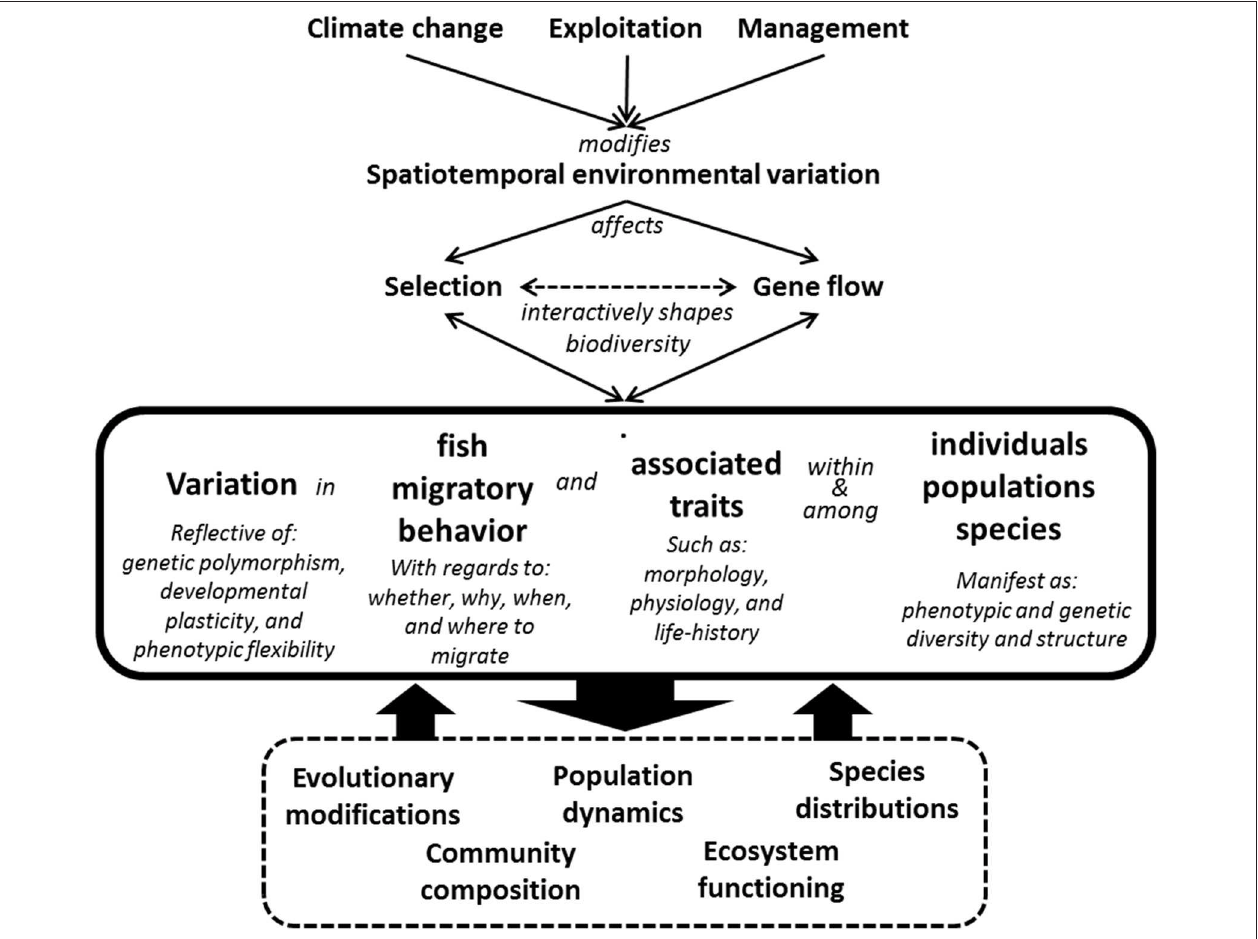
FIGURE 1 | Overview of causes and consequences of variation and flexibility in fish migration. Fish migratory behaviors and associated phenotypic traits vary within and among individuals, populations and species. The phenotypic differences are reflective of the combined contributions of genetic differences, developmental plasticity, and phenotypic flexibility. The costs and benefits of migratory behaviors are context dependent in that they vary according to individual attributes (see Table 1 ) and are influenced by interactive ecological and evolutionary processes in response to spatiotemporal environmental heterogeneity. Climate change and anthropogenic activities result in environmental makeovers and can further modify the opportunities for migration, the direction and strength of selection, genetic diversity, and structure, population dynamics, species distributions, and community composition. Patterns of variation in fish migratory behaviors thus represent the outcome of complex and dynamic eco-evolutionary feed-back